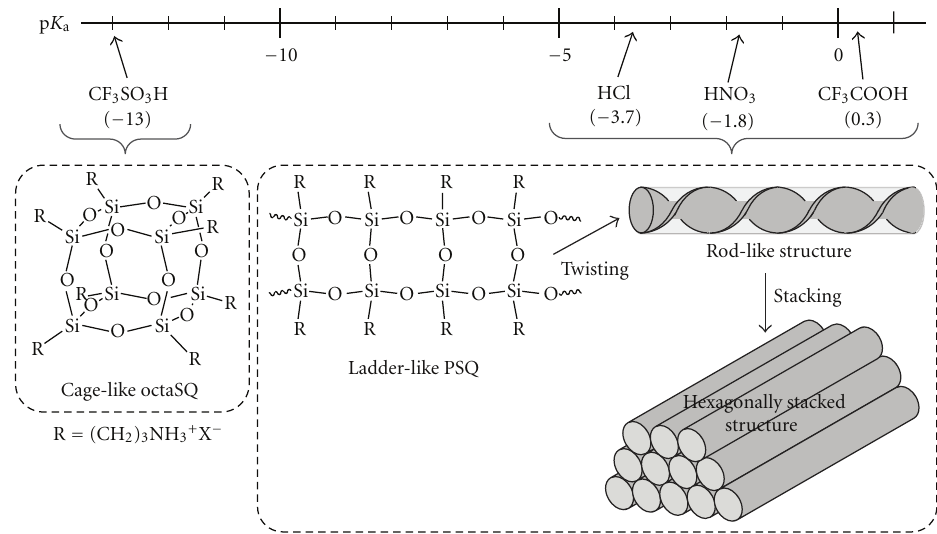
Figure 8: Correlation between the p K a of acid-catalysts and the structures of SQs prepared by hydrolytic condensation of